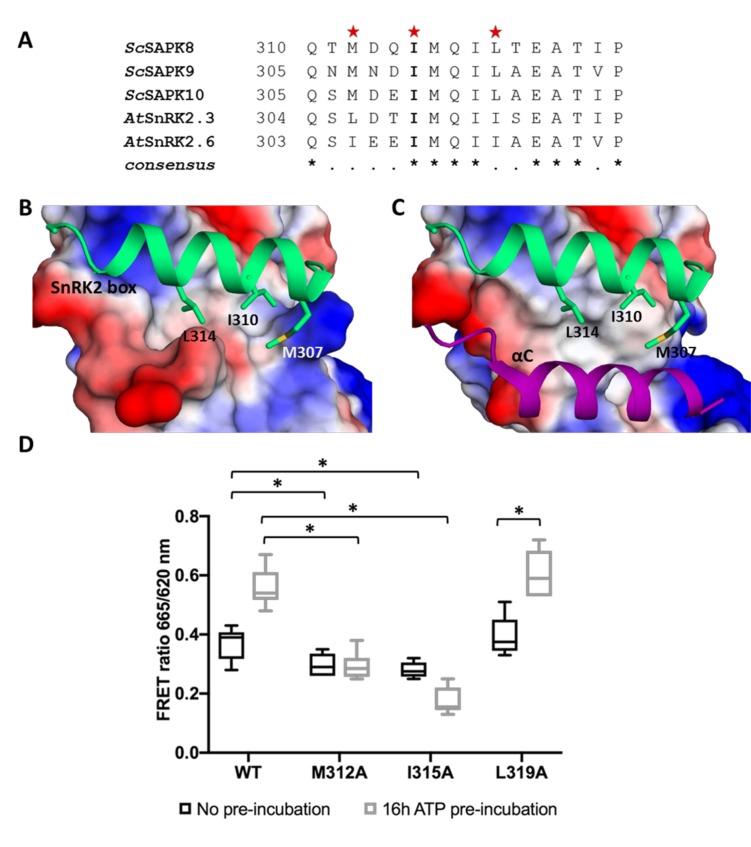
Key residues for SnRK2 box and αC helix interaction are conserved in ScSAPK10 and affect protein activity. (A) Alignment of SnRK2 box residues from sugarcane SAPKs, SnRK2.3, and SnRK2.6. Red stars represent the residues chosen for site-directed mutagenesis. The residue I315 is conserved in sugarcane and Arabidopsis SnRK2s while the residues M312 and Leu319 are conservatively substituted. (B) Cartoon representation of SnRK2 box (green) from ScSAPK10_∆nterm-∆ABA-box structure. ScSAPK10 SnRK2 box residues M307, I310, and L314 (homologous to ScSAPK8 M312, I315, and L319) are displayed as sticks and make close contact with the αC helix surface. The electrostatic potential analysis shows the negative potential (in red) of the αC surface. The positive potential is represented in blue. (C) Cartoon representation of SnRK2 box (green) and the αC helix (purple) from ScSAPK10_∆nterm-∆ABA-box structure. The electrostatic potential of αC surface was hidden to show the helix position. (D) Box plot of the enzymatic activity of ScSAPK8 WT and the mutants M312A, I315A and L319A after ATP incubation. The data show the quantity of phosphorylated peptide produced, measured by the ratio of fluorescence intensity at 665 nm (streptavidin-XL665 emission excited by phospho-specific Eu-cryptate conjugated antibody) and 620 nm (Eu-cryptate emission). In both assay conditions, the observed activity for ScSAPK8 WT was significantly higher than the mutants M312A (*p = 0.0416 for no ATP pre-incubation and *p < 0.0001 for 16 h ATP pre-incubation) and I315A (*p = 0.0114 for no ATP pre-incubation and *p < 0.0001 for 16 h ATP pre-incubation). The L319A activity was similar to WT in both conditions but significantly increased with 16 h of ATP pre-incubation (*p < 0.0001).